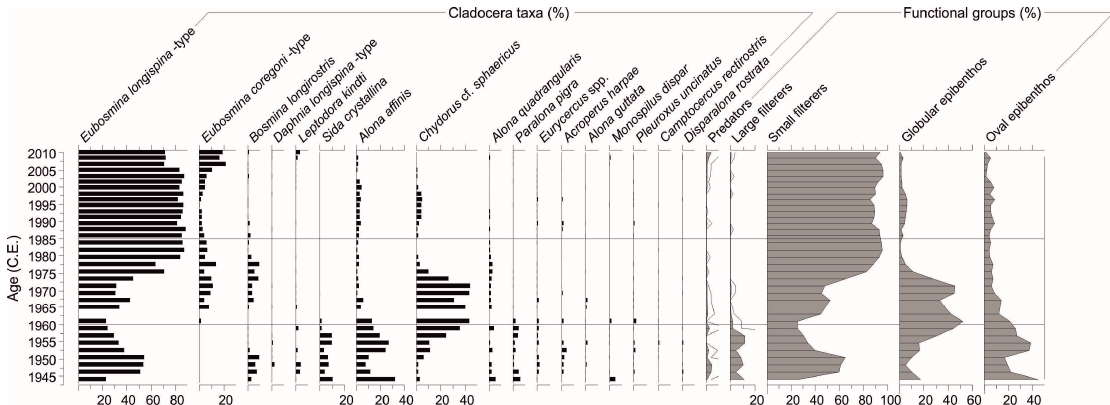
Figure 4. Relative abundances of most abundant fossil cladoceran taxa and functional groups in Lake Maggiore sediment core. The horizontal lines define the reference (pre-1960), eutrophication (1960–1985), and recovery (post-1985) periods.